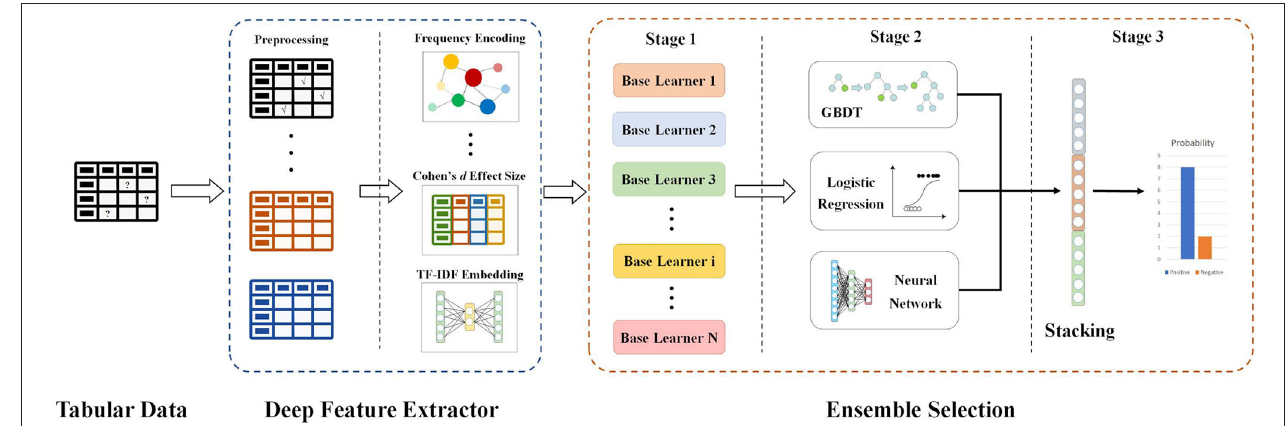
FIGURE 1 | Flow chart and network architecture of our proposed model.